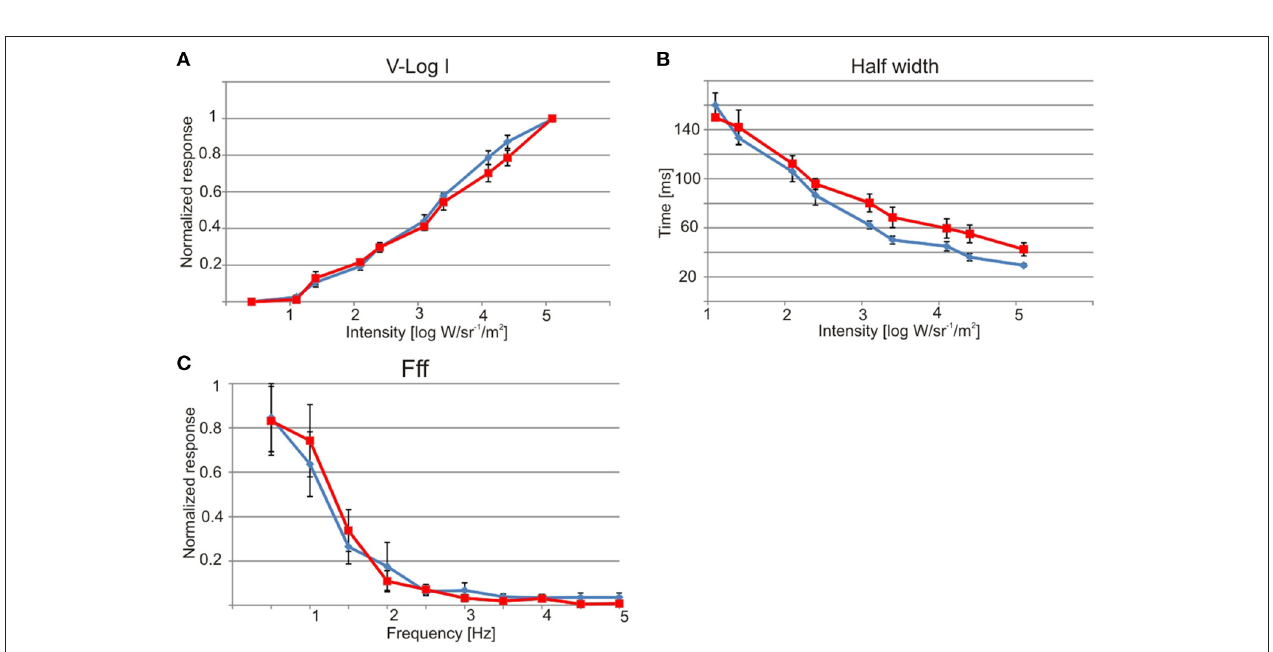
FIGURE 3 | Examples of ERGs. (A) Recordings from an upper lens eye showing the graded impulse response to 25ms flashes of light (red line) covering four log units. Note also the longer time to peak with declining light intensity. (B) Recording from a lower lens eye showing the responses to 1, 2, and 3Hz sinusoidal light stimuli (red traces). Note that the response peaks before max intensity at 1Hz.